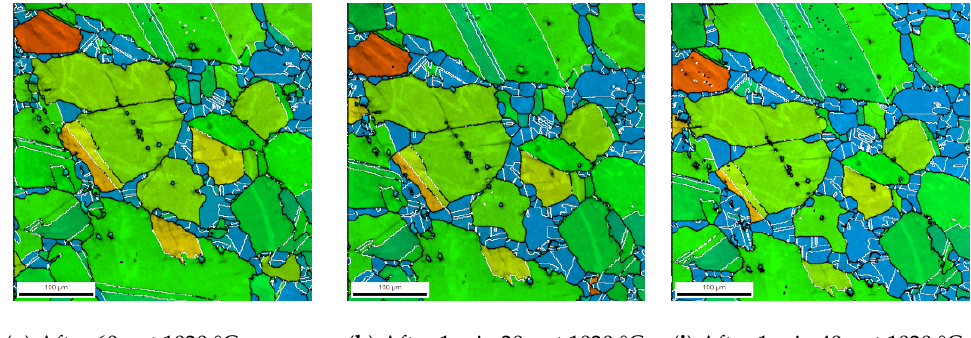
Figure 3. Microstructure evolution of sample A (initial DRX volume fraction = 2%) after successive post ‐ dynamic annealing steps at 1020°C (cumulated holding times are indicated below each micrograph). Intragranular misorientation GOS maps superimposed with the Pattern Quality map. Scale bar: 100 µ m. Grain boundaries (>15°) in black and twin boundaries (60° <111>) in white. GOS color-coding from 0 to 9°: